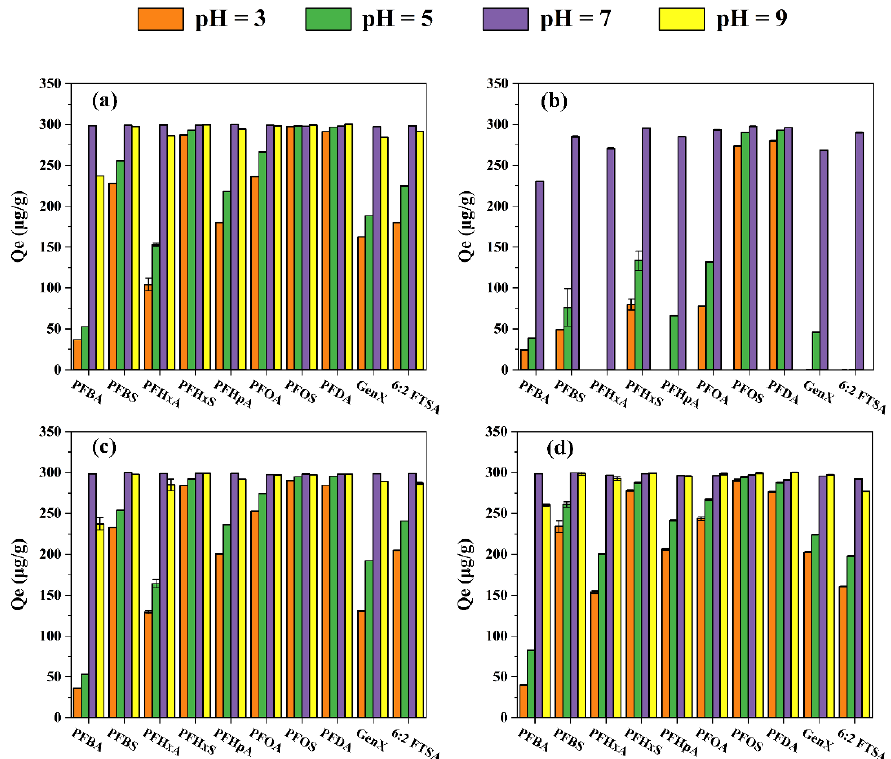
Figure 6. Adsorptive removal of PFASs by various resins under different pH conditions: ( a ) ( b ) WA10; ( c ) S6368; ( d ) HPR4700; ( b ) WA10; ( c ) S6368; ( d ) A111S.